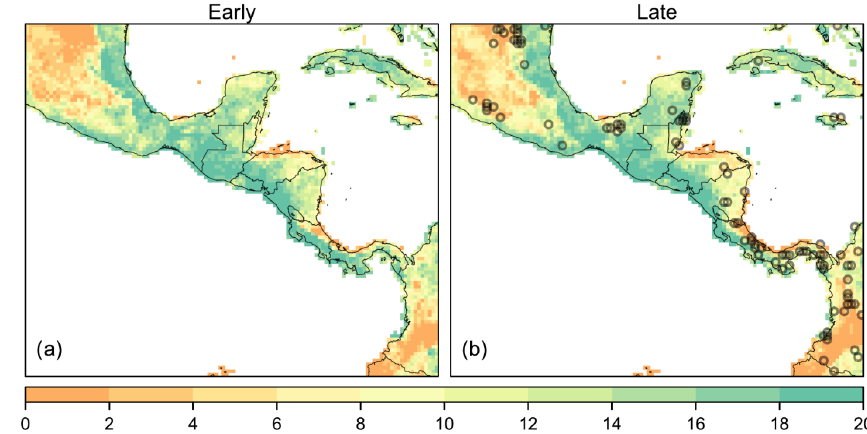
Figure 3. Number of years out of 20 with an MSD in (a) the early period (1981–2000) and (b) the late period (2001–2020). Circles in panel (b) indicate the difference in proportions of MSD years in the two periods is statistically significant based on Fisher’s exact test.